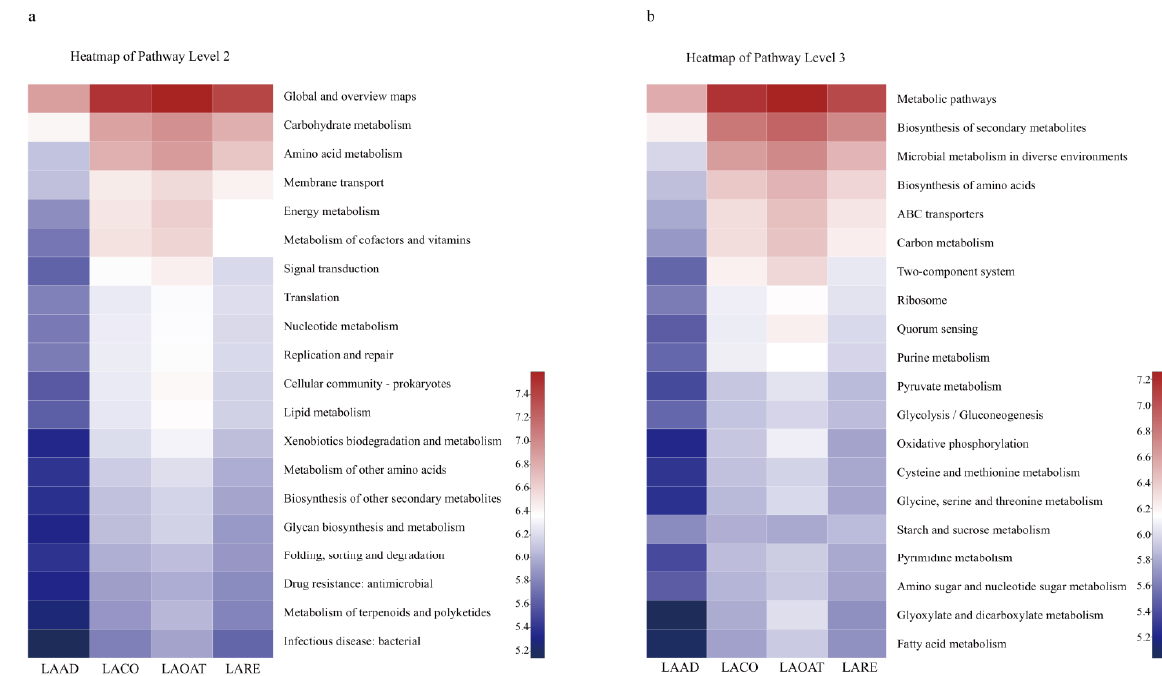
Figure 5. Prediction of KEGG functions for C. suppresallis gut bacteria reared on different diets. ( a ) Function prediction in pathway level two. ( b ) Function prediction in pathway level three. LAAD: larvae fed on an artificial diet, LACO: larvae fed on a corn diet, LARE: larvae fed on a rice diet, and LAOAT: larvae fed on a water oat diet.